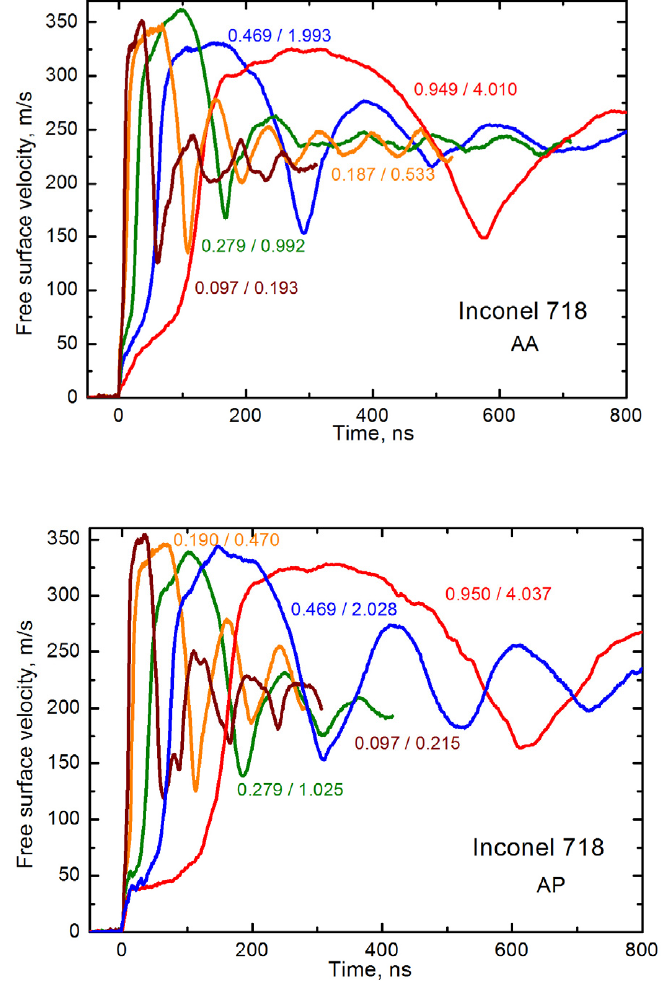
Figure 4. Velocity histories of Inconel 718 alloy samples of various thicknesses manufactured by additive technology without subsequent thermal treatment, loading along (AA) and perpendicular (AP) to the direction of surfacing. Experimental conditions are indicated in Table 3. The thicknesses of the impactors and the samples are indicated for each profile by the same color.